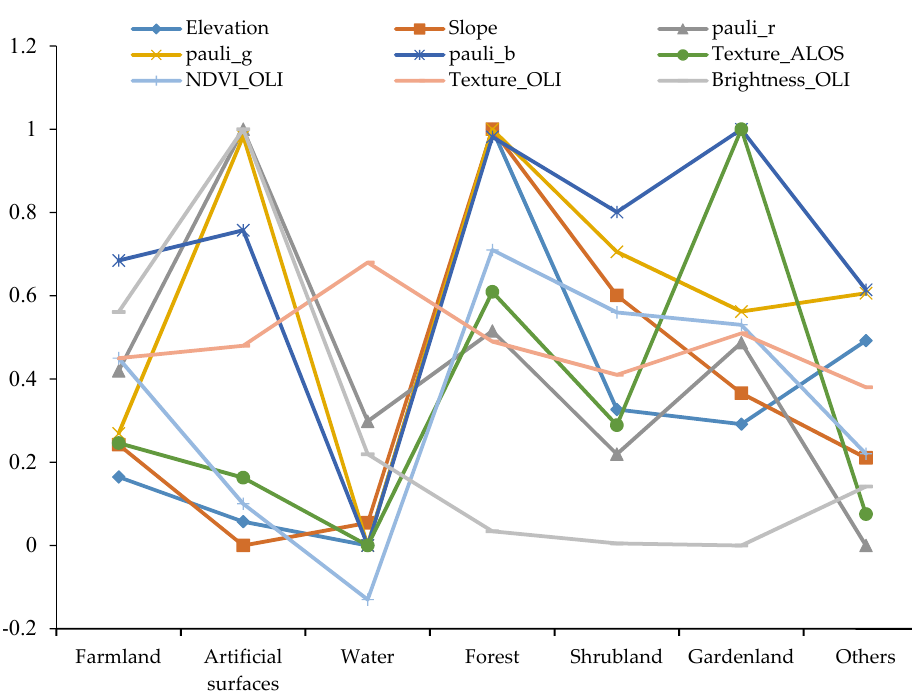
Figure 11. Classification features of synthetic aperture radar (SAR) and OLI optical images.